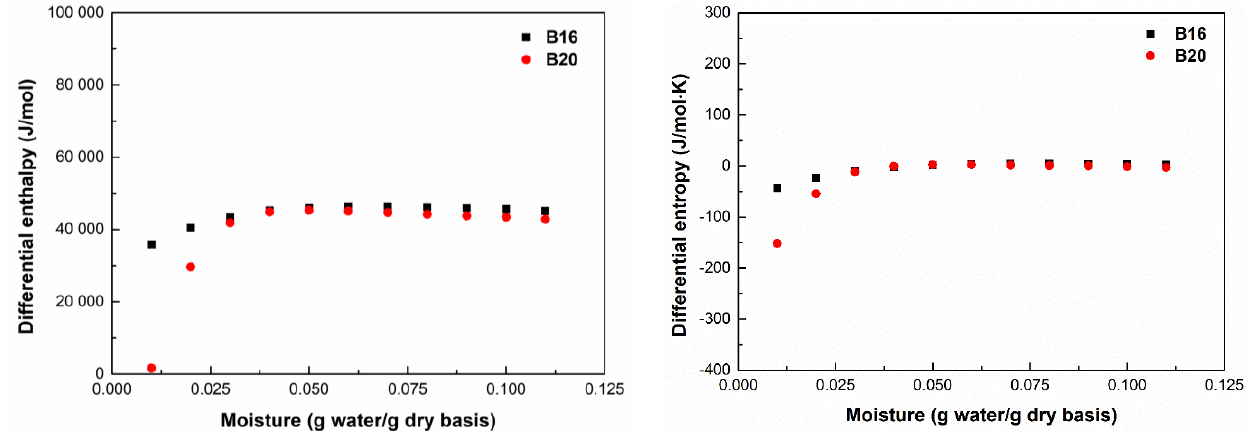
Figure 4. Differential enthalpy and entropy values of adsorption as a function of equilibrium moisture contents for B16 and B20.